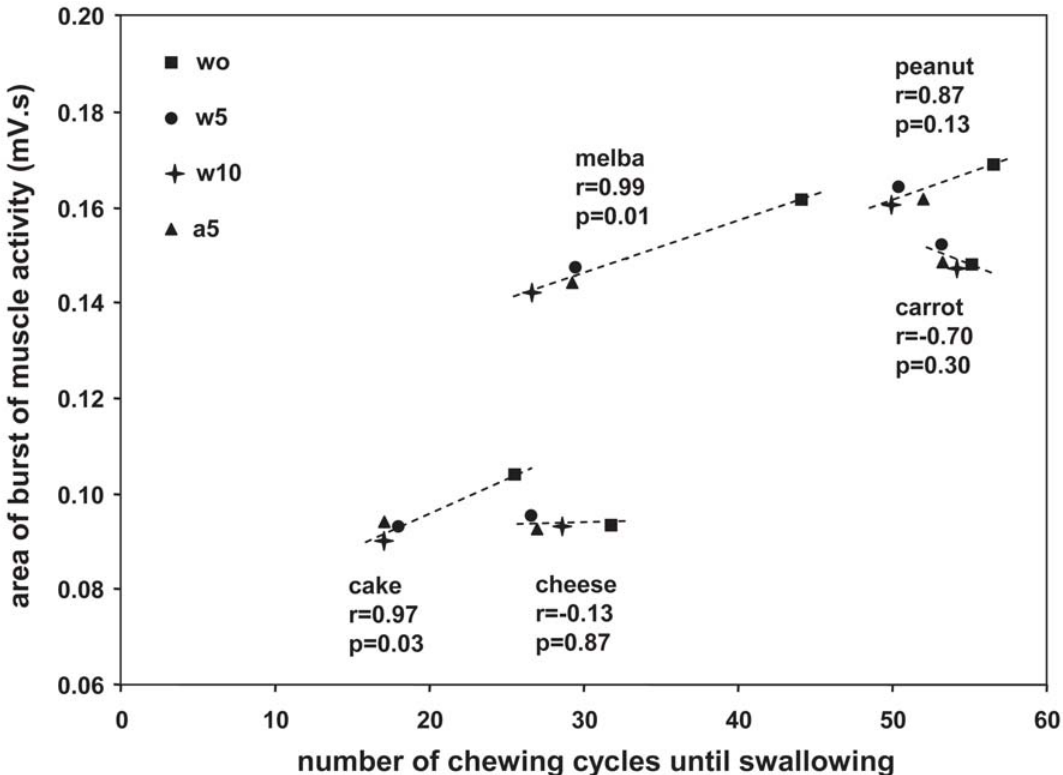
FIGURE 1- Means for muscle electromyographic activity area and number of chewing cycles for the different foods and fluids. wo: without fluid; w5: 5 mL water; w10: 10 mL water; a5: 5 mL α -amylase